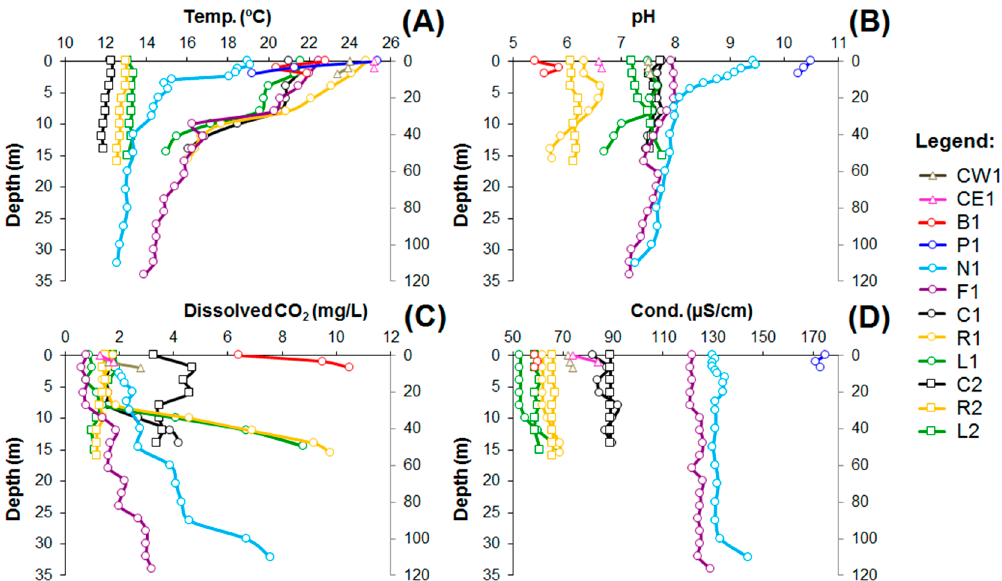
Figure 3. Geochemical profiles for several physico-chemical parameters: ( A ) temperature; ( B ) pH; ( C ) electrical conductivity; ( D ) dissolved CO 2 for the Corvo and Flores lakes (CW1—Caldeirão West, first survey; CE1—Caldeirão East, first survey; B1—Branca, first survey; P1—Patos, first survey; N1— Negra, first survey; F1—Funda, first survey; C1—Comprida, first survey; R1—Rasa, first survey; L1— Lomba, first survey; C2—Comprida, second survey; R2—Rasa, second survey; and L2—Lomba, second survey). The sampling took place in July 2016 (survey 1) and March 2017 (survey 2). The right vertical scale on several plots is only for Negra Lake.